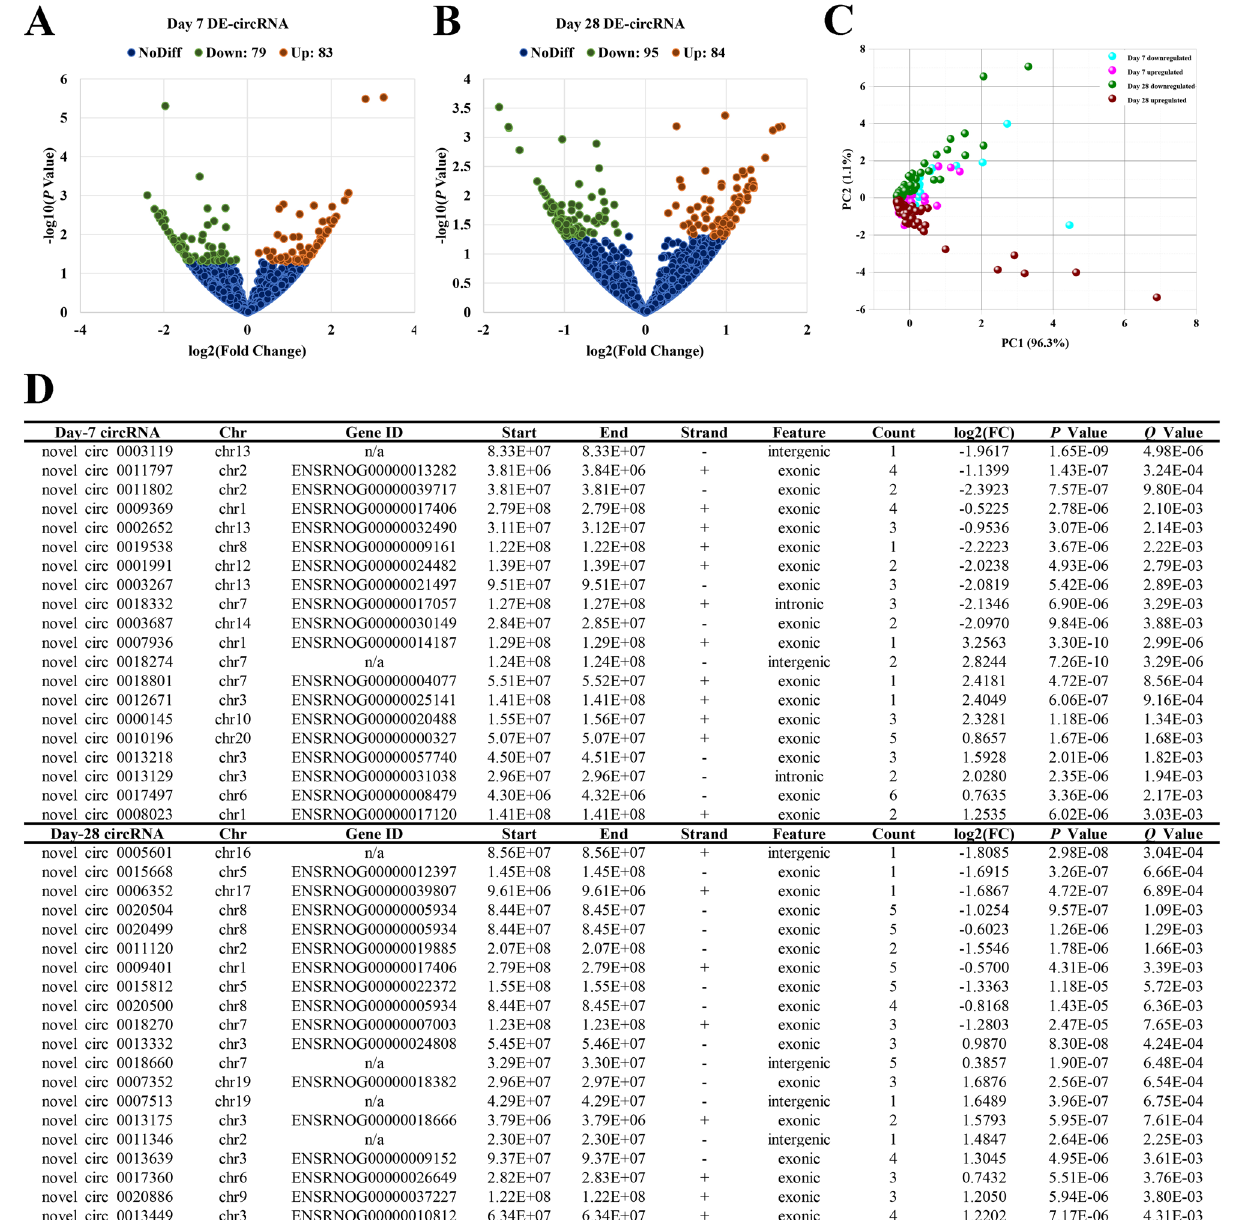
Figure 1. Differences in the circRNA expression profile between Sham and ICH groups. ( A ) Volcano plot showed differential expression of circRNAs between Sham and ICH groups on the 7th day. ( B ) Volcano plot showed differential expression of circRNAs between Sham and ICH groups on the 28th day. ( C ) PCA plot revealed the discrimination between day-7 and day-28 samples. ( D ) Top 10 differentially downregulated and top 10 differentially upregulated circRNAs, in ICH samples, on days 7 and 28, respectively. The horizontal line in the volcano map represented the fold (log 2 scaled) down or up changes; the vertical line represented a corrected P value of 0.05 (-log 10 scaled); green spots indicated the differentially down-expressed RNAs with statistical significance; red spots indicated the differentially up-expressed RNAs with statistical significance; blue spots indicated RNAs with no statistically significant expression. The variances explained by the principal components chosen were shown as PC1 and